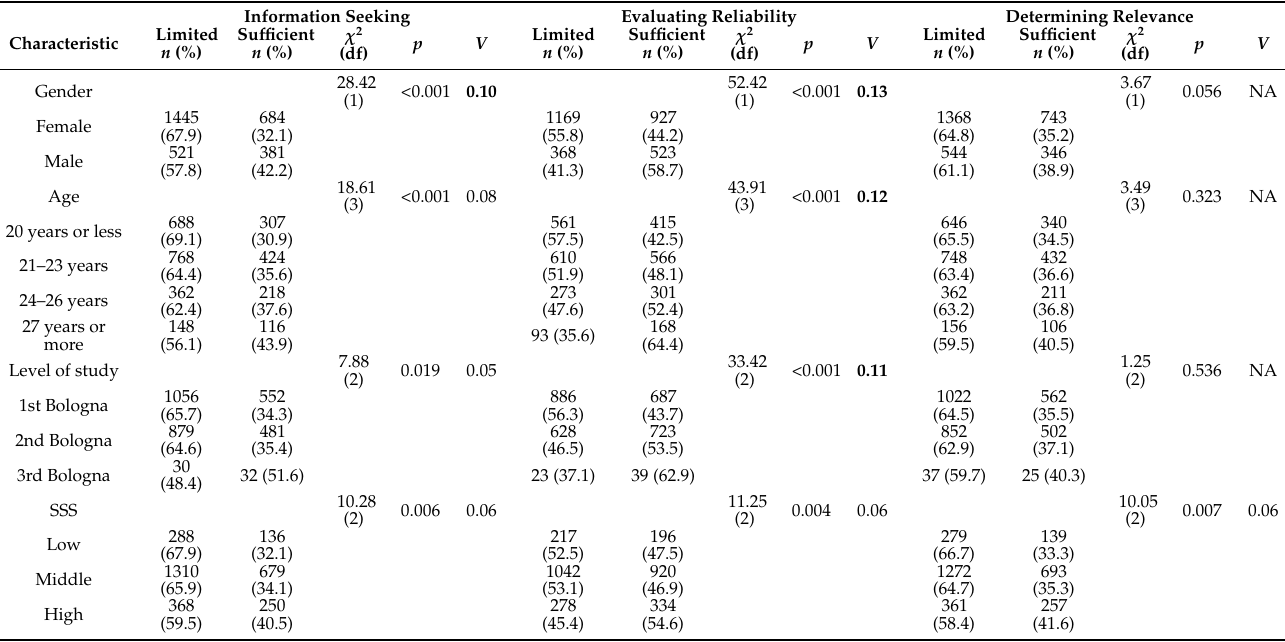
Table 3. DHL stratified by sociodemographic